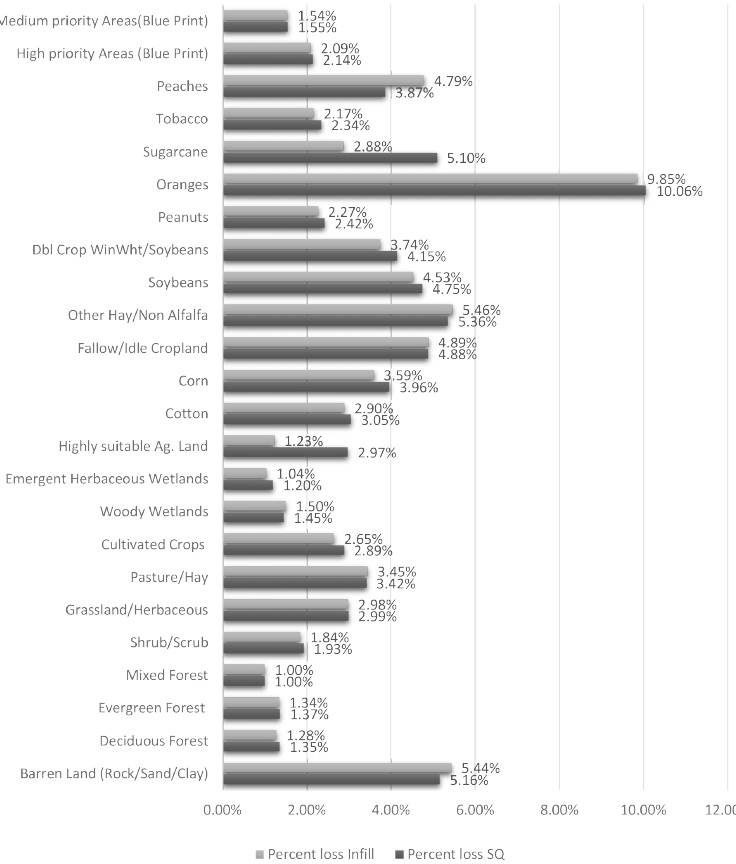
Figure 4. Percent loss (average simulated 2050/total 2011) for land covers/uses, croplands, productive farmlands and conservation priority areas under the Status Quo and Infill urban growth